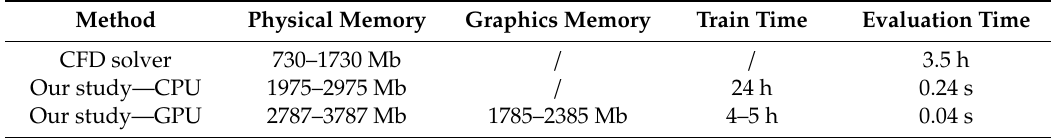
Table 3. Comparison of computation costs with di ff erent methods.